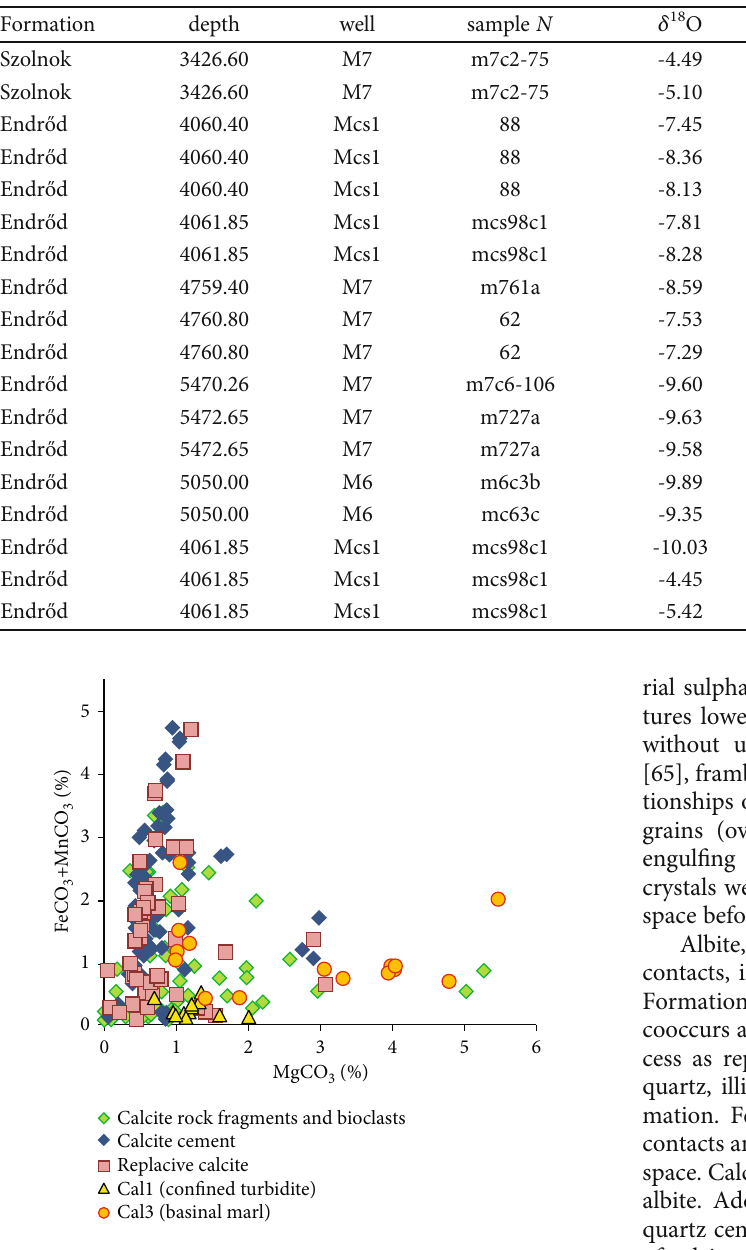
Figure 15: Elementary composition of